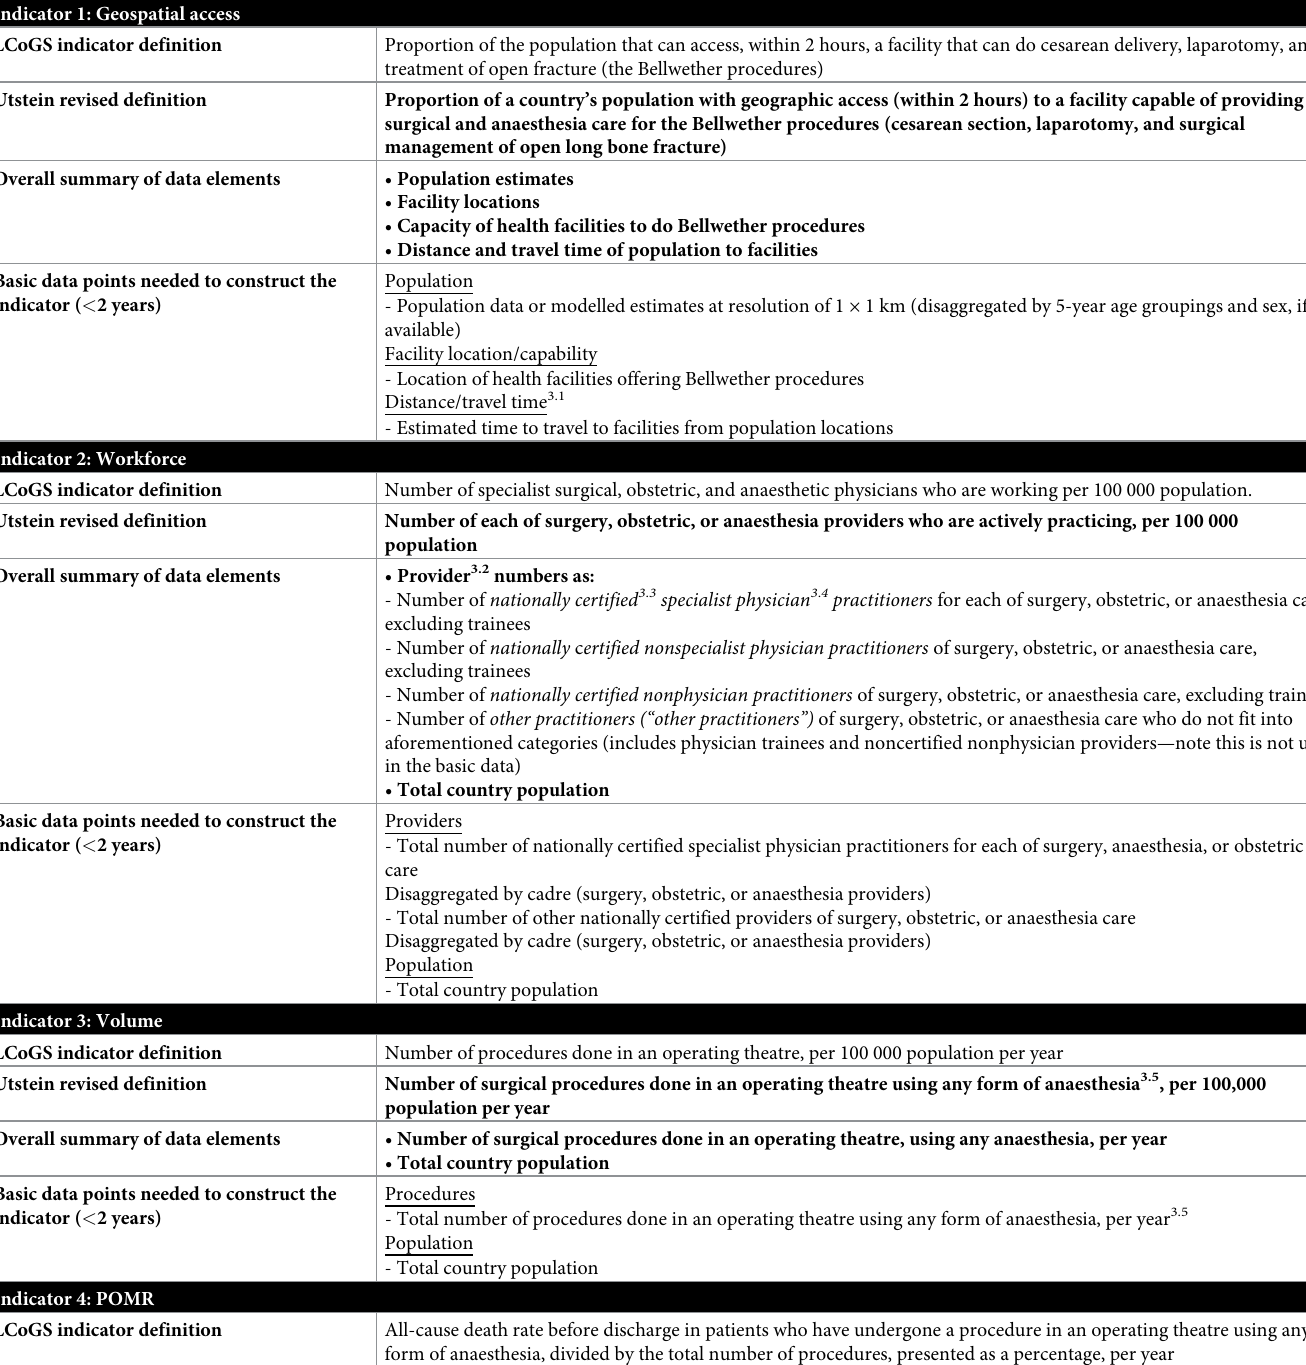
Table 3. Revised LCoGS indicators and basic data